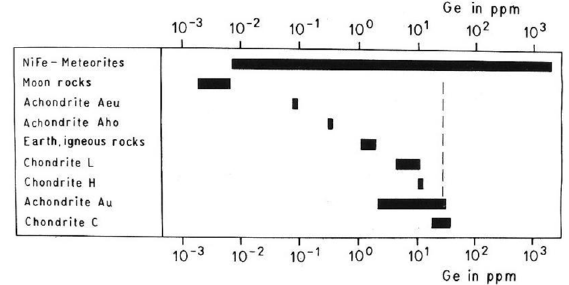
Figure 3. Germanium content of iron and stony meteorites of various classes, moon rocks, and terrestrial igneous rocks. The dashed line shows the solar-system abundance of Ge (Schrön